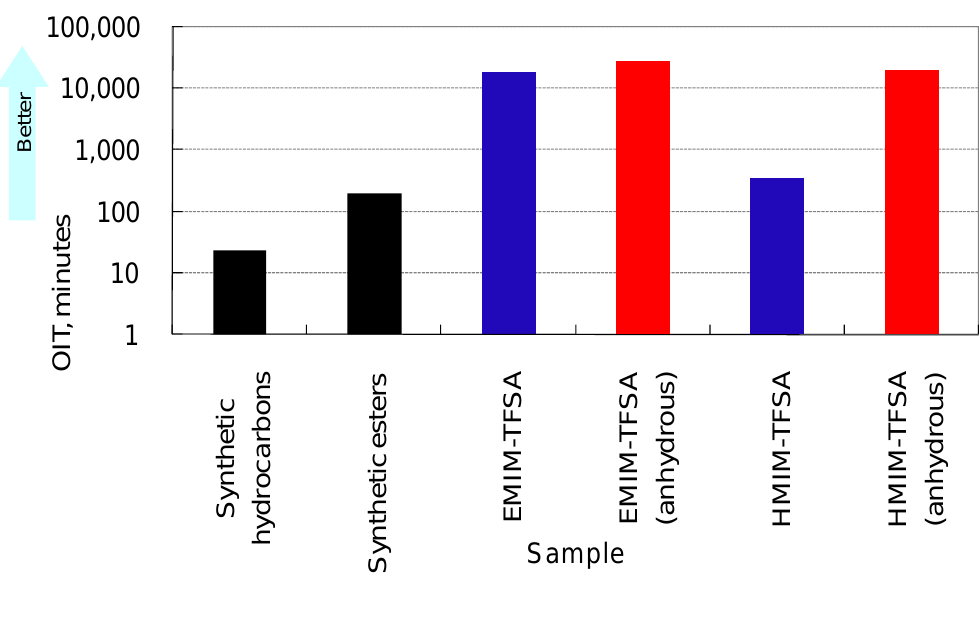
Figure 12. Results of the Rotating Bomb Oxidation